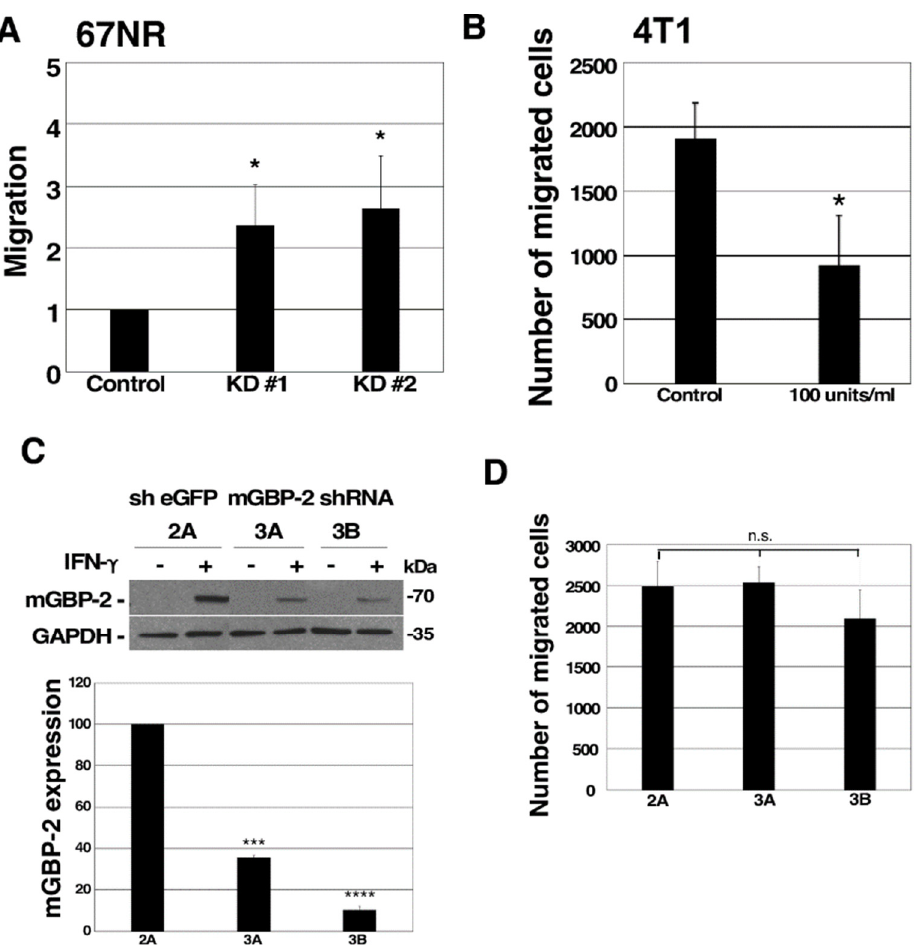
Figure 3. mGBP-2 inhibits 67NR cell migration but is not required for IFN- γ -mediated inhibition of migration. ( A ) Control, KD #1 and KD #2 67NR cells were seeded on Boyden chamber inserts coated with fibronectin. FBS (20%) in DMEM was added to the bottom well. Cells were allowed to migrate for 5 hrs. Membranes were processed and analyzed as described. All migrated cells were counted manually using ImageJ cell counter software. The graph presents the average migrated cells ± S.D. relative to control shRNA (sh eGFP 2A, which was assigned an arbitrary value of 1 (*, p < 0.05, n = 3). The number of control cells that migrated ranged between 573 and 2167. ( B ) 4T1 cells were pre- treated with or without 100 U/mL IFN- γ for 24 h. They were then plated onto Boyden chambers in the presence or absence of IFN- γ and analyzed as described. The average number of migrated cells ± SD are shown (*, p < 0.05, n = 3). ( C ) Lysates from 4T1 cells expressing mGBP-2 shRNA or control shRNA (sh eGFP) and treated with 100 U/mL IFN- γ for 24 h, were analyzed for mGBP-2 and GAPDH. A representative blot is shown ( n = 2). The ratio of mGBP-2 and GAPDH densitometric values were calculated and represented on the graph as the average mGBP-2 expression ± S.D rela- tive to control shRNA (sh eGFP 2A), which was assigned an arbitrary value of 100 (***, p < 0.001, ****, p < 0.0001, n = 2). ( D ) 4T1 cells containing sh eGFP 2A, sh eGFP 2B, and two clones of mGBP-2 shRNA 3 (mGBP-2 shRNA 3A and mGBP-2 shRNA 3B) (5 × 10 4 ) were pretreated with or without 100 U/mL IFN- γ for 24 hrs. The cells were plated onto Boyden chambers, allowed to migrate for 5 h, and analyzed as described. All migrated cells were counted using ImageJ software. The average number of migrated cells ± SD are shown ( p = 0.5775, n = 2). n.s. = not significant.